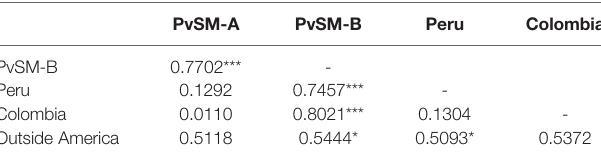
TABLE 3 | F ST values within P. vivax PvSM lineages from southern Mexico and between them and parasites from other geographical origins based on gene sequences of ookinete